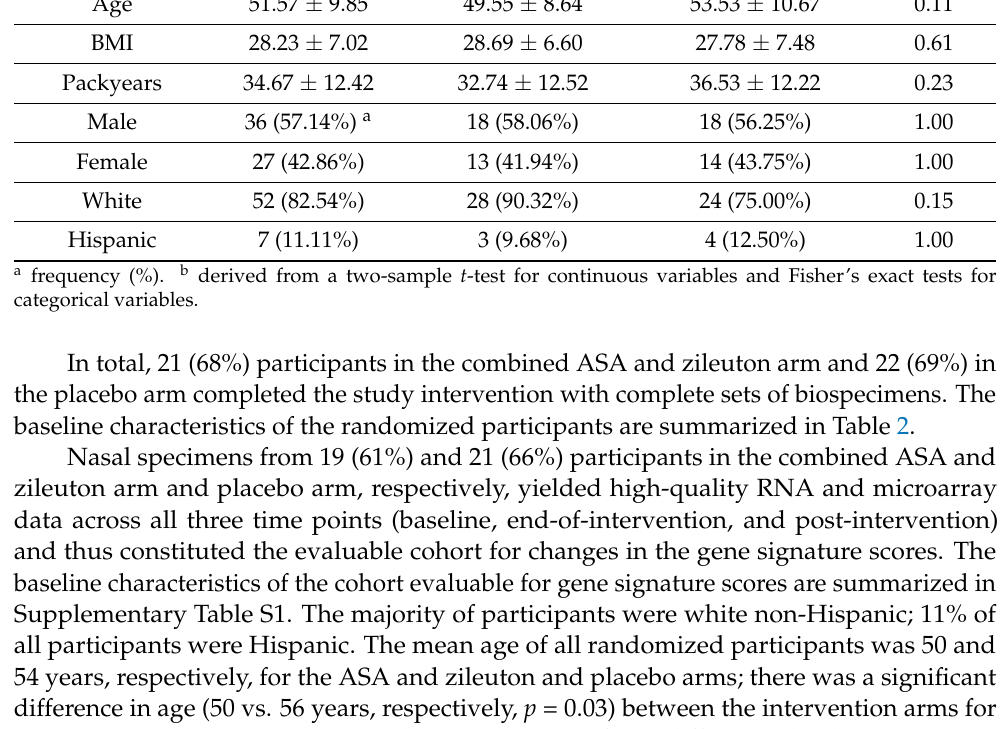
Table 1. Baseline characteristics of the randomized participants; data is presented as mean ± stand- ard deviation.